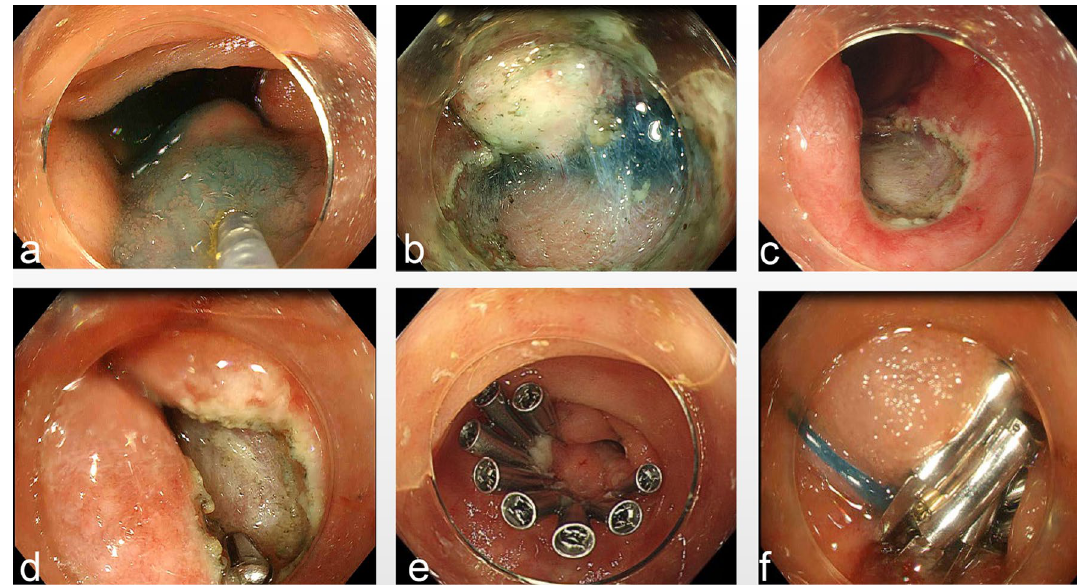
Figure 3. ( a ) Submucosal injection. ( b ) Dissection of the lesion along the muscularis propria. ( c ) Hemostasis of the wound surface using heat forceps. ( d ) The muscle layer of the wound surface was intact after the operation. ( e ) The wound was closed by a hemostatic clip. ( f ) Hemostatic clip-assisted nylon suturing for the